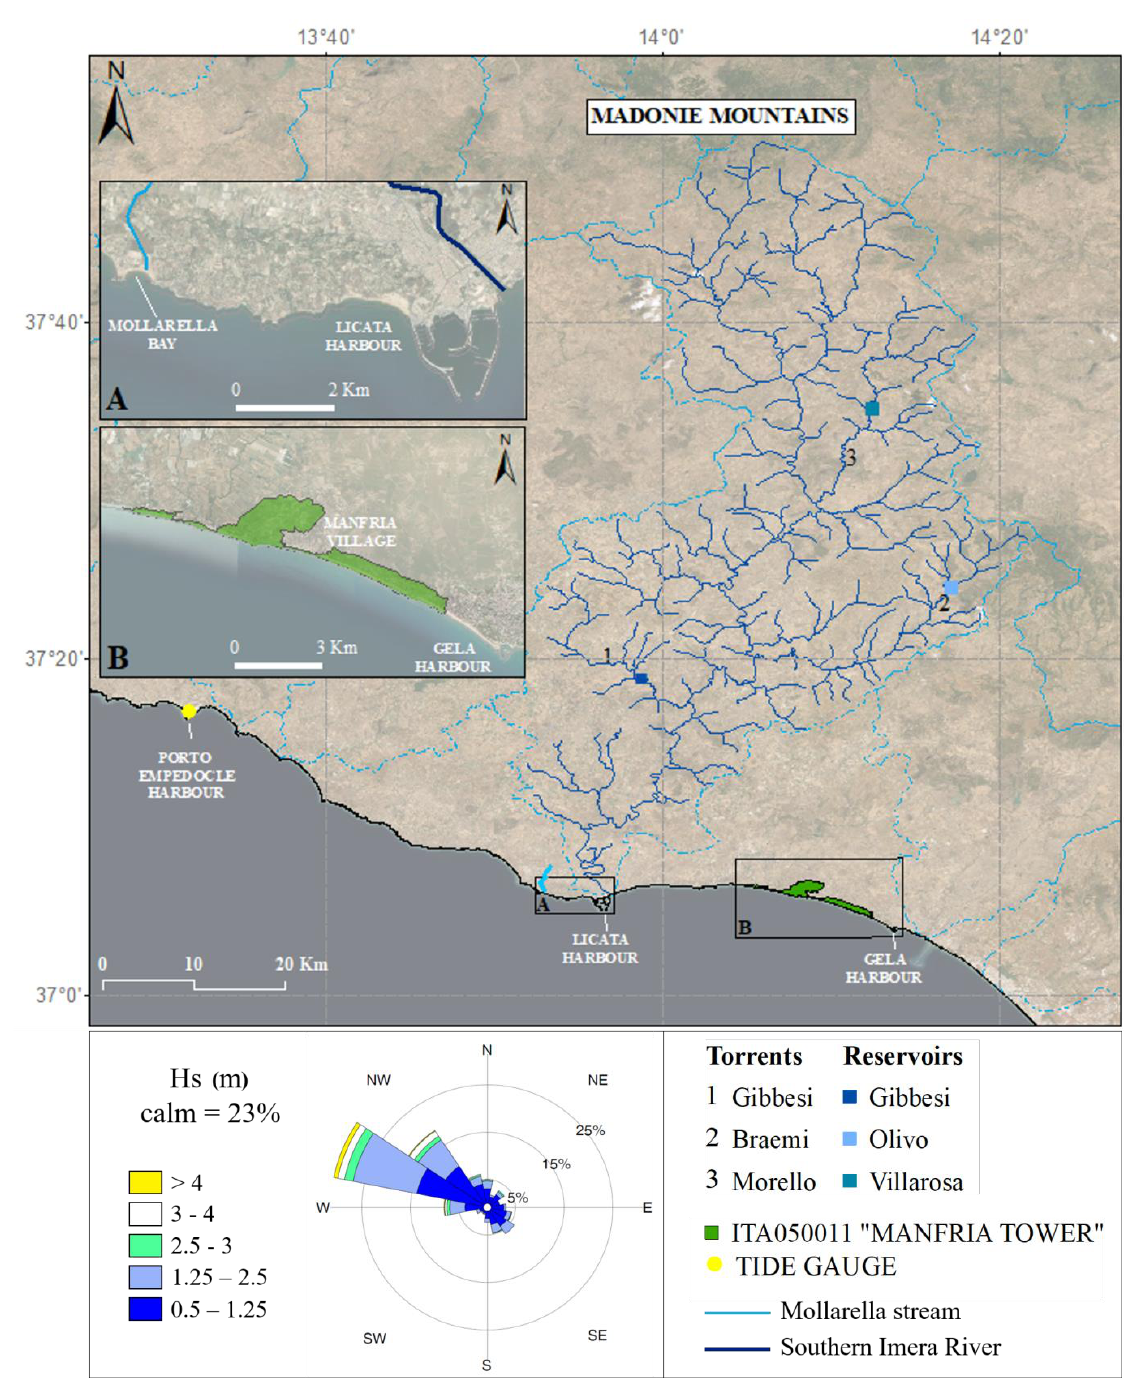
Figure 2. Southern Imera drainage basin, with tributaries and artificial reservoirs, location of the tide gauge station at Porto Empedocle (yellow dot) and the Site of Community Importance (SCI) ITA 050011 “Manfria Tower” (green poly- gon). ( A ) Location of the present-day Southern Imera River mouth and the disused second river mouth, in correspond- ence of Mollarella Bay, ca. 6 km from the Licata harbour. ( B ) Details of the Site of Community Importance (SCI) ITA 050011 “Manfria Tower”.